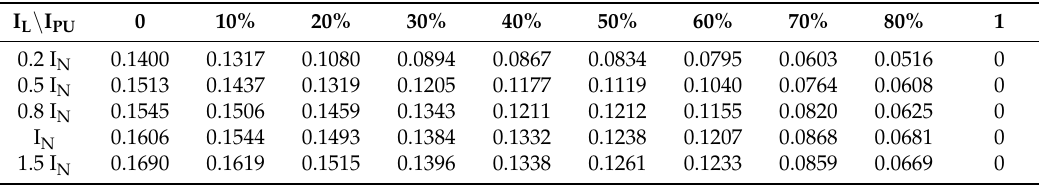
Table 4. Average loss decrement per-unit value in half cycle of single-phase PWM converter under different current thresholds and different load currents.